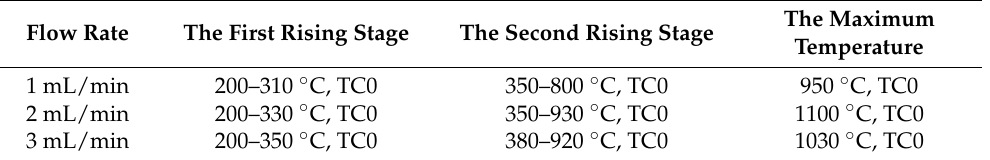
Figure 8. Temperature and pressure curve of a model thruster with the convergent nozzle at a 3 mL/min flow rate. Table 3. Two rising stages of the temperature curves of a model thruster with the convergent nozzle at the flow rate of 1~3